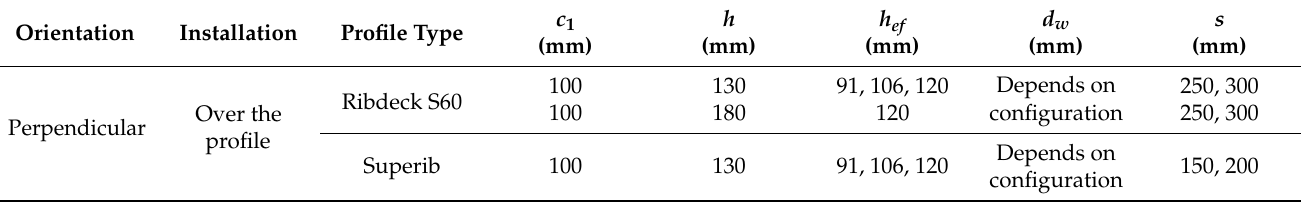
Table 5. Series 3—anchor channel over the decking profile, perpendicular to the decking profile.